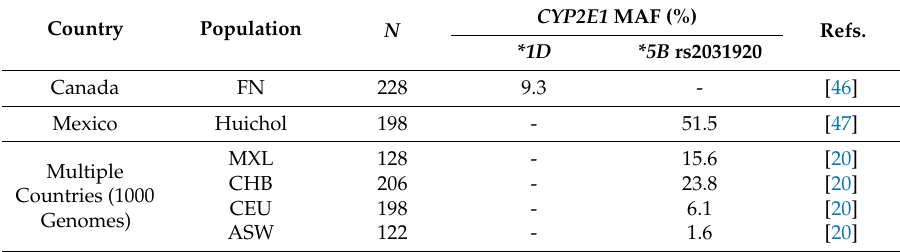
Table 10. Comparison of CYP2E1 allele frequencies Indigenous North American populations to global populations from the 1000 Genomes Project [20]. N represents the number of alleles. Global populations are abbreviated as follows: African Ancestry in Southwest US (ASW); Utah residents with Northern and Western European ancestry (CEU); Han Chinese in Beijing, China (CHB); Mexican Ancestry in Los Angeles, California